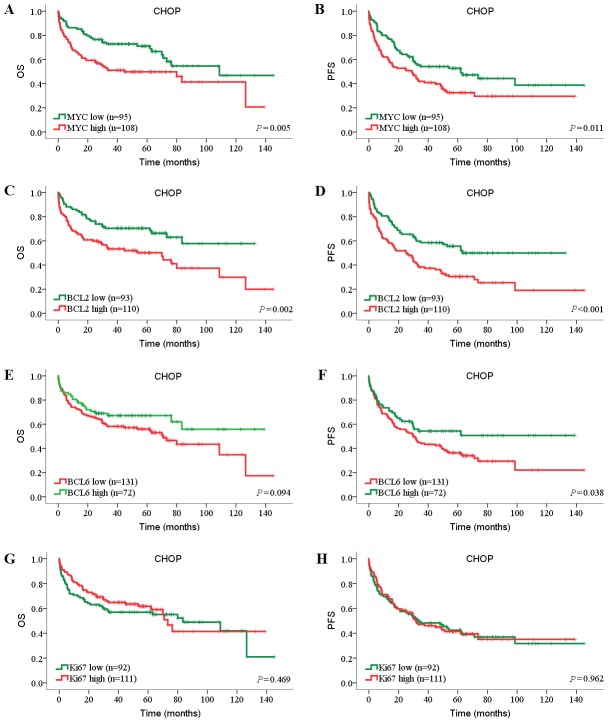
Prognostic impact of MYC, BCL2, BCL6 and Ki67 expression in DLBCL patients treated with CHOP.Patients’ tumors were stained for (A, B) MYC, (C, D) BCL2, (E, F) BCL6, and (G, H) Ki67. The numbers of patients showing negative or positive stainings (MYC≥40%, BCL2≥70%, BCL6≥50%, Ki67≥90%), cut-off values, and P values are indicated.